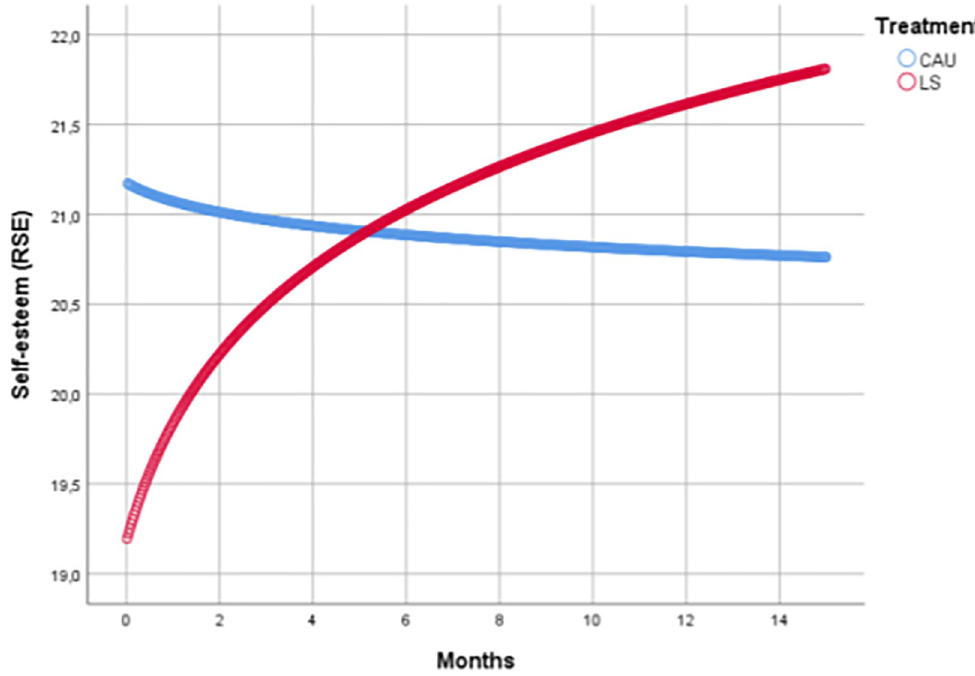
Fig 3. Self-esteem scores over time.